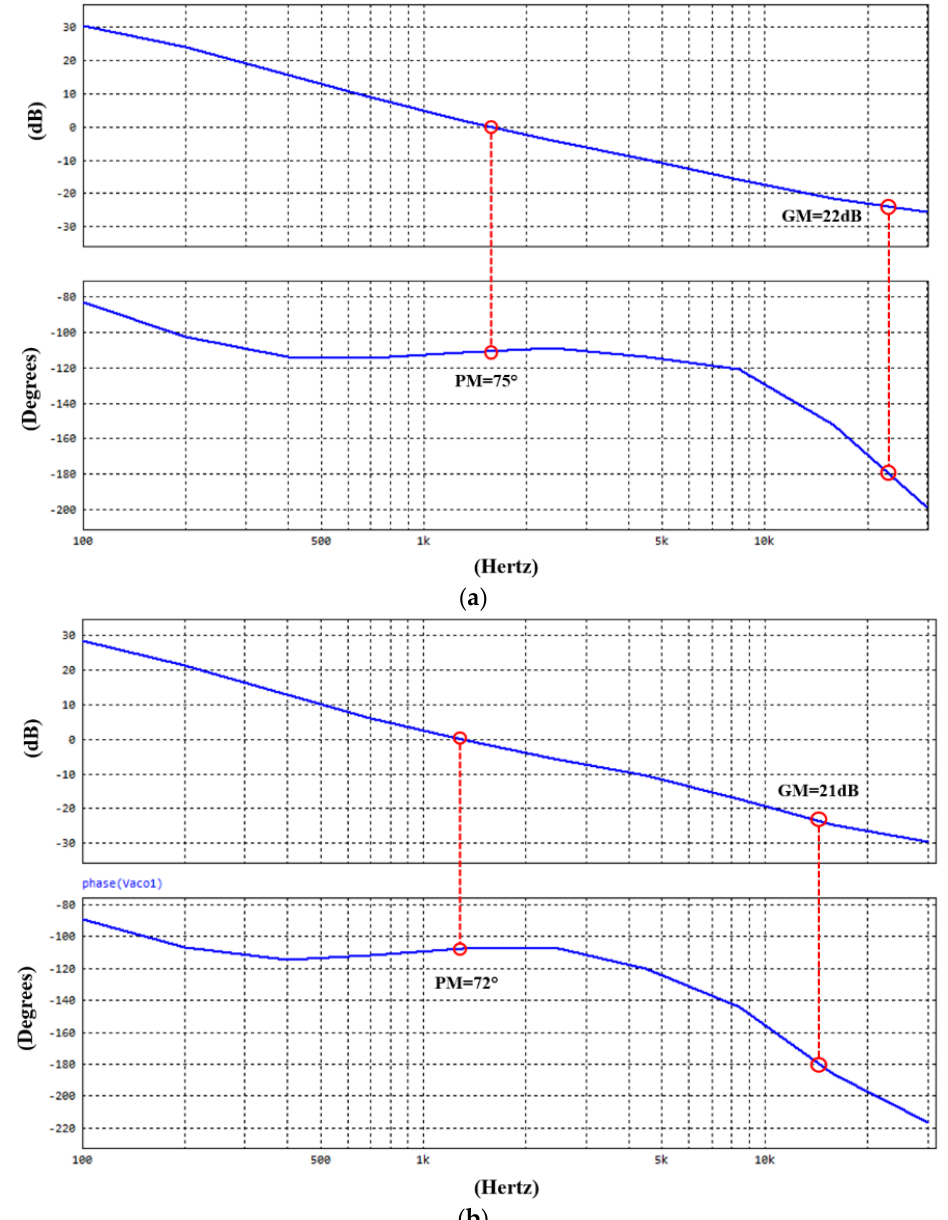
Figure 29. Bode plots of the power electronics system under closed-loop regulation. ( a ) Closed-loop bode without the output transformer, and ( b ) closed-loop bode with the output transformer.